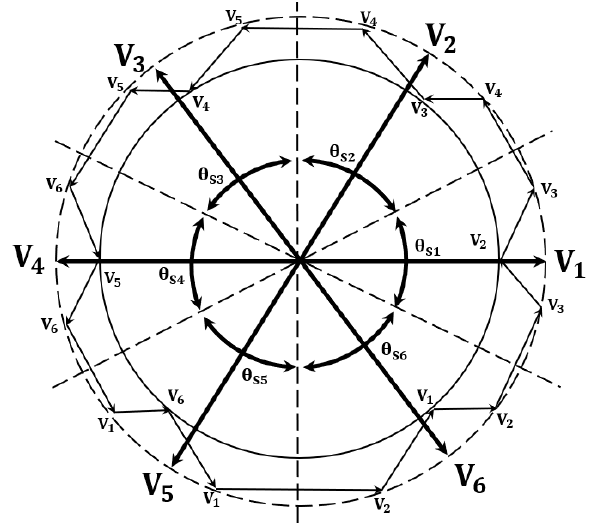
Figure 2. Stator flux trajectory according to the voltage vector command under conventional DTC using LUT (lookup table). Table 1. LUT (lookup table) used for conventional DTC control.